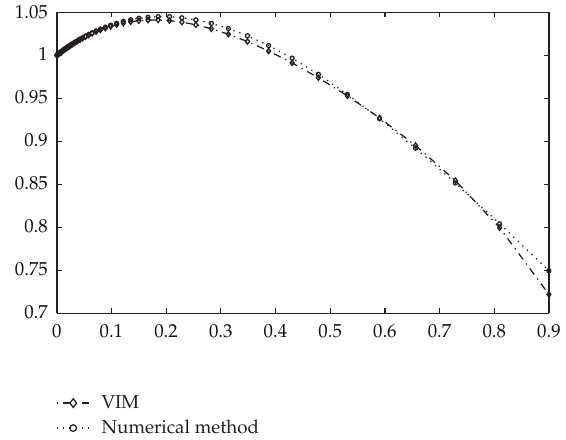
Figure 2: Time response for x ΔΔ (cid:10) (cid:7) 0 . 1 (cid:10) 2 . 5 x (cid:8) x Δ (cid:10) x (cid:10) x 2 (cid:6) 0 with 3